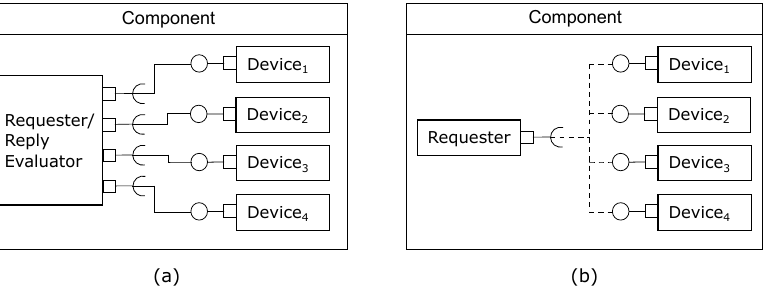
Figure 20. Choosing a single reply among the replies from many providers: ( a ) Existing design: The requester contains the behavior for multicasting the requests and evaluating the replies. ( b ) Updated design: Using an enhanced connector to multicast requests and evaluate the replies.